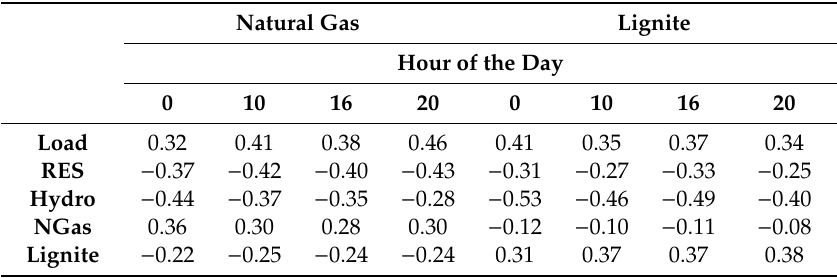
Table 1. Coe ffi cients of the long-run equilibrium relationship for natural gas- and lignite-fueled